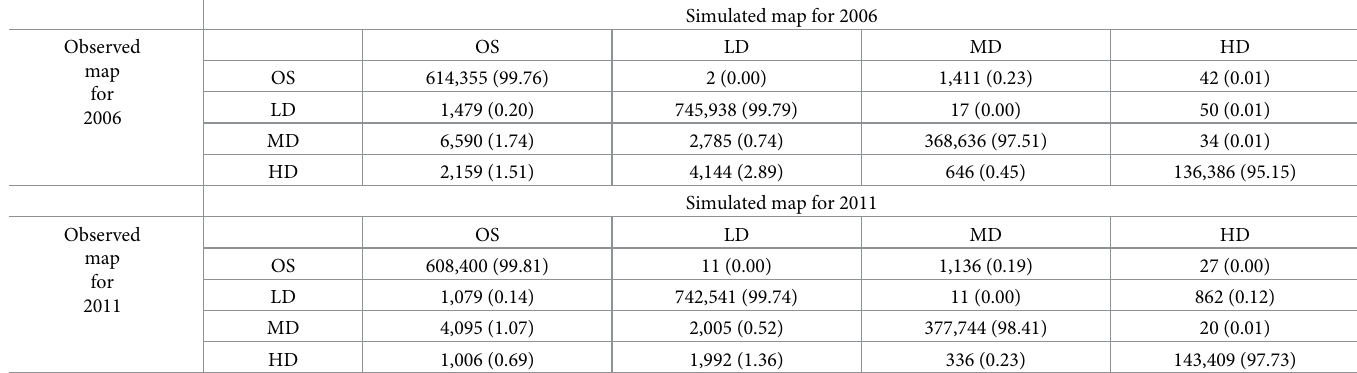
Table 6. Confusion matrix for 2006 and